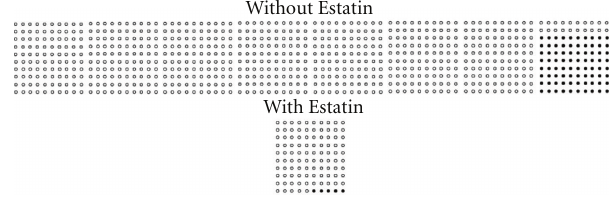
Figure 1: Numerical information about relative risk reduction and additional visual information (icon array). A new drug for reducing cholesterol, Estatin, decreases the risk of dying from a heart attack for people with high cholesterol. Here are the results of a study of 900 such people: 80 out of 800 of those who did not take the drug died of a heart attack, compared with 5 out of 100 of those who took the